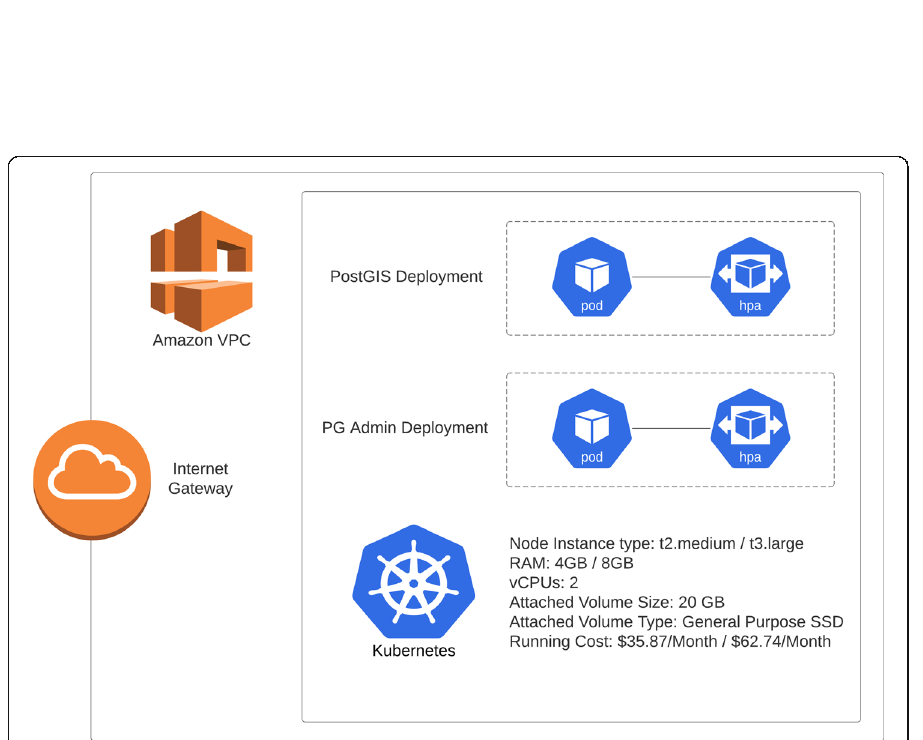
Fig. 4 Cloud infrastructure setup for deploying PostgreSQL/PostGIS on AWS